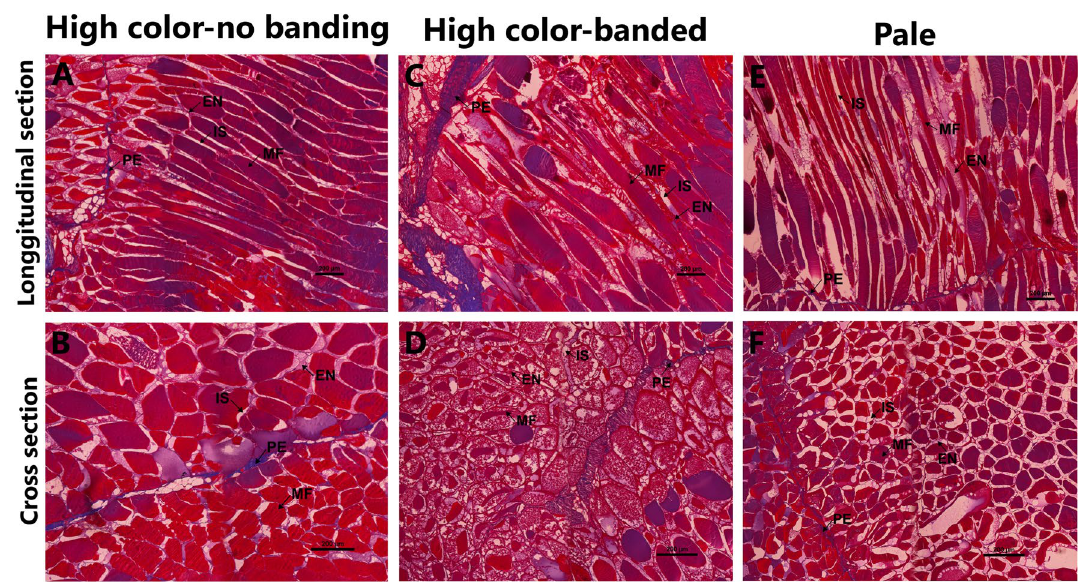
Figure 3. Histological sections of the back central (BC) muscle region showing structural variations among HN ( A , B ) HB fish ( C , D ) and Pale fish ( E , F ). Panels ( A , C , E ) present longitudinal sections, while panels ( B , D , F ) show cross sections, scale bar: 200 µm. MF muscle fiber, PE perimysium, EN endomysium, IS interstitial